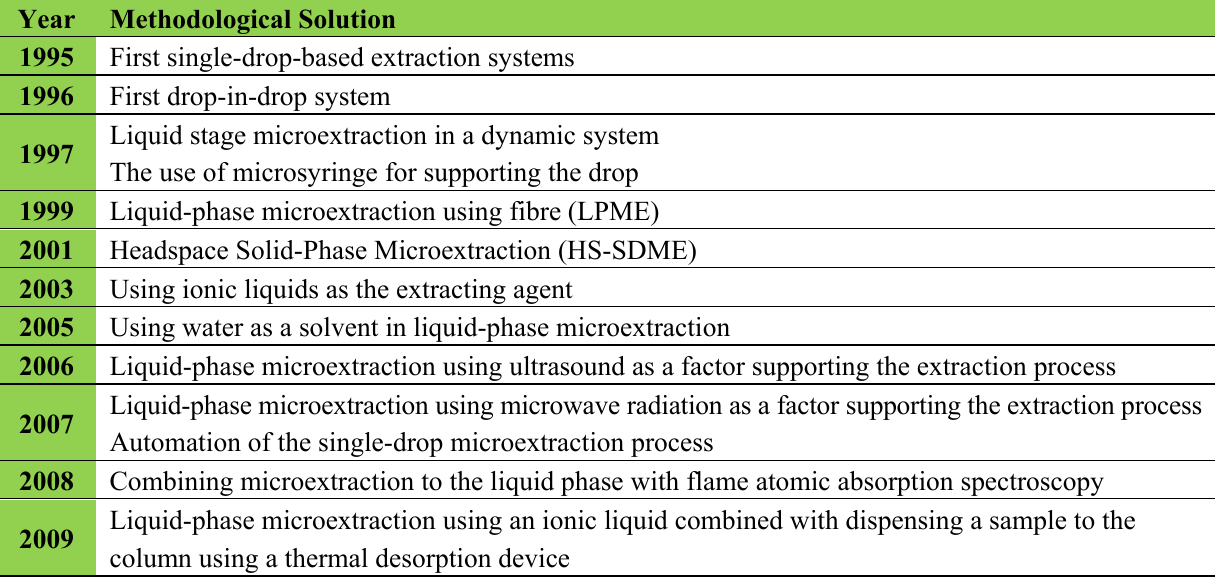
Table 1. Stages of the development and improvement of the LPME technique [6].